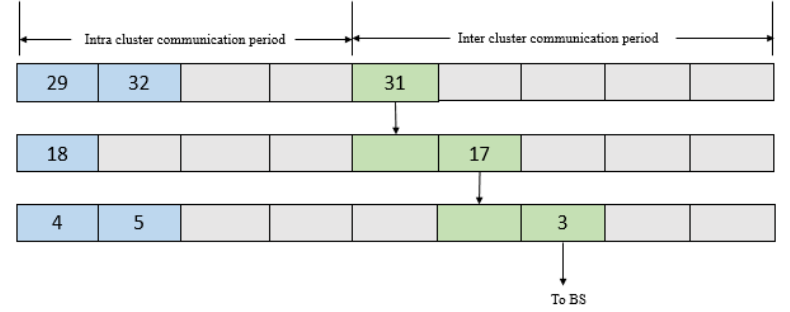
Figure 1. The network architecture in the Proposed Model.